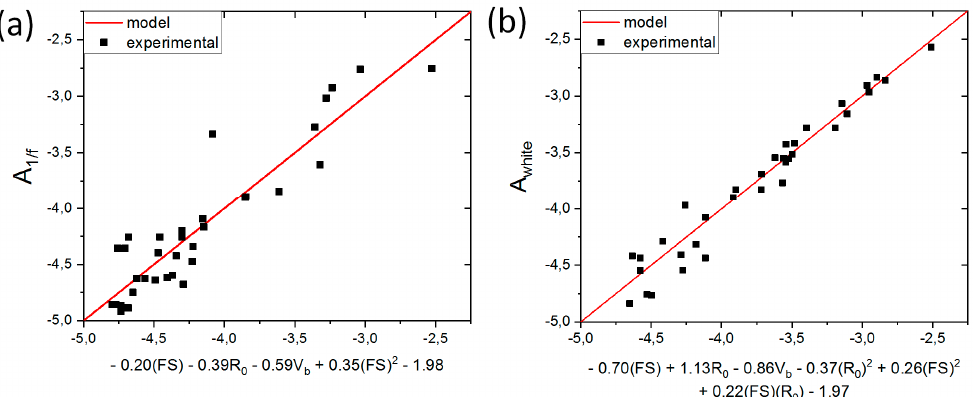
Figure 5. Illustration of the model prediction found for: 1/f-type noise ( a ); and white noise ( b ). In both charts, the respective noise coefficient is shown as a function of the specific expression identified, for both the regression model (red line) and the experimental data (black squares). All variables presented in this chart are logarithmized.